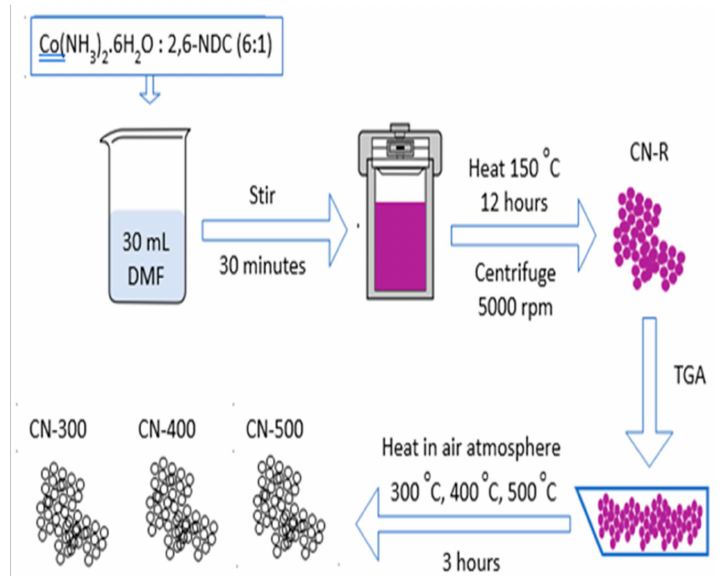
Figure 1. Procedure of the